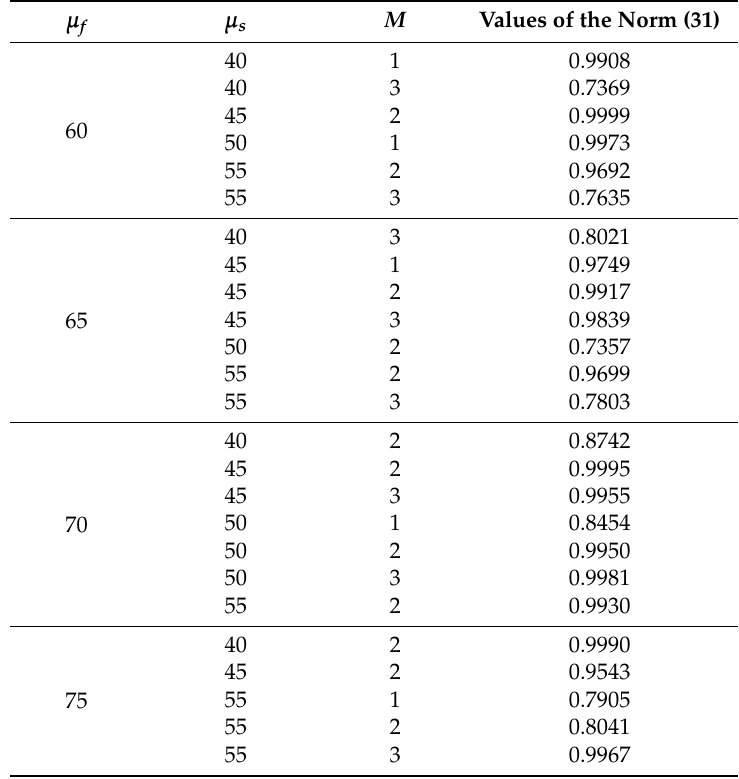
Table 3. Accuracy of the developed algorithm for calculation of steady-state probabilities. Case of autocorrelated arrivals of MMPP